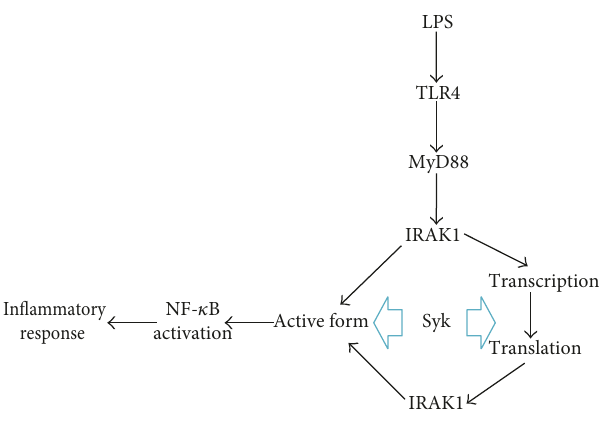
Figure 4: Schematic pathway for Syk regulation of IRAK1 expression and